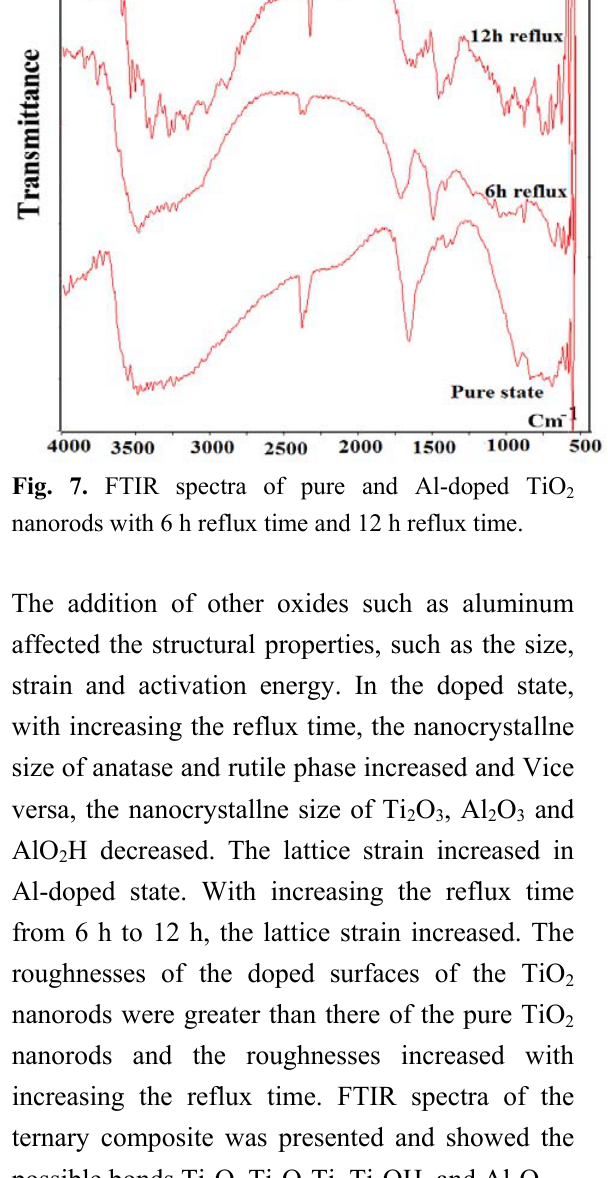
Table 4 . Roughness parameter of TiO 2 nanorods .